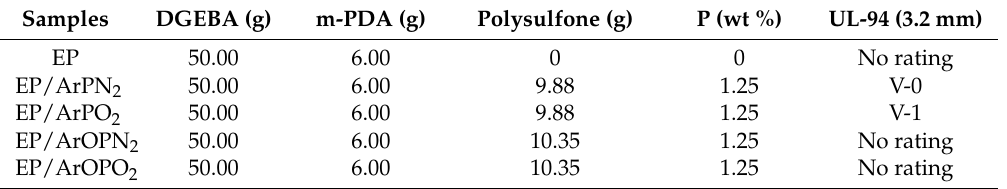
Table 1. Compositions and vertical burning tests results of all epoxy